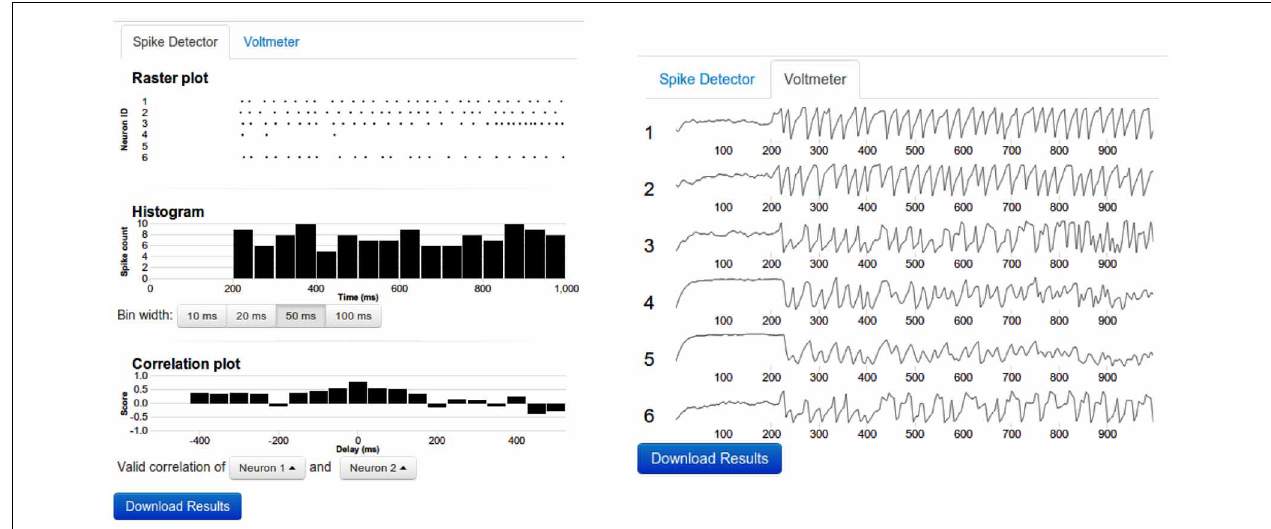
FIGURE 3 | Sample output. Left : The top panel shows the raster diagram of spikes of every neuron that was connected to a spike detector device. The middle panel depicts the Peri Stimulus Time Histogram (PSTH) of the population activity. The bottom panel shows the cross-correlogram of the activity of two neurons. The bin width of the PSTH and cross-correlograms are same. By clicking on the diagram,